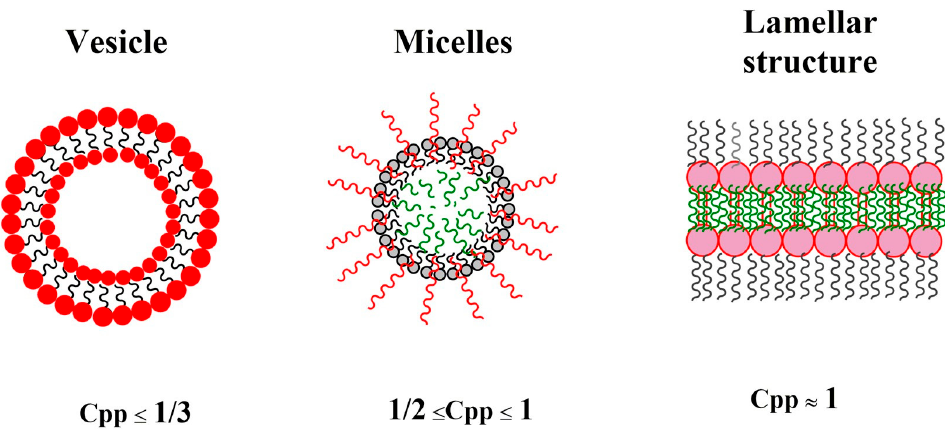
Figure 11. Variation of Critical Packing Parameter (Cpp) with Nanocarrier Morphology.